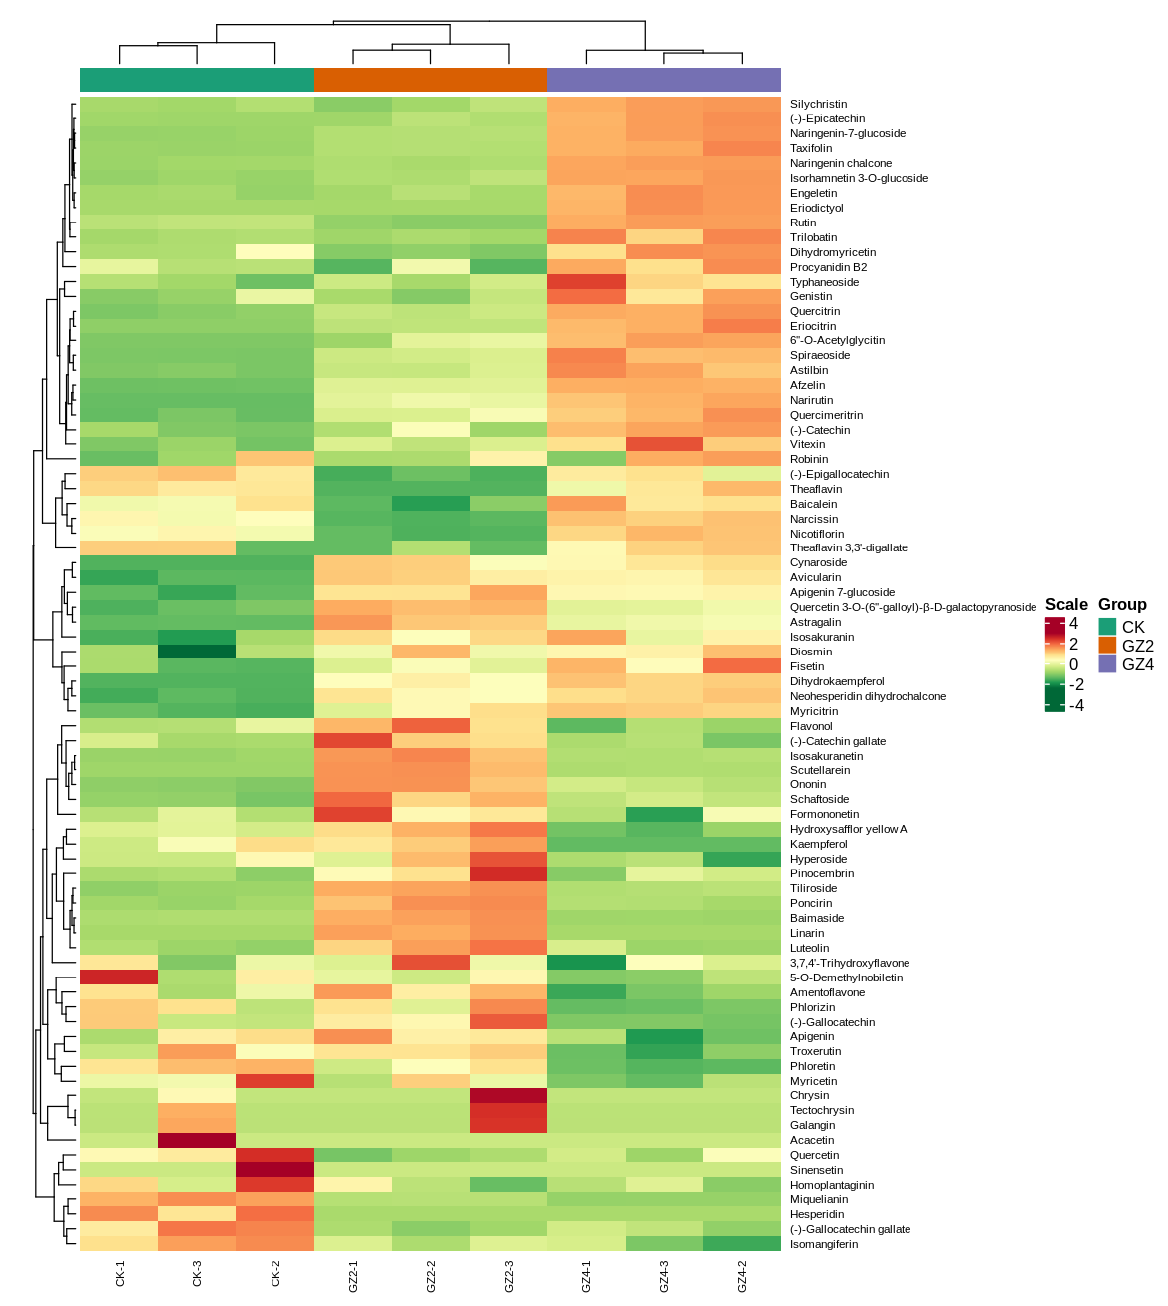
Figure 2. Heatmap of 78 flavonoid metabolites. The data on the flavonoid metabolite contents were normalized for hierarchical cluster analysis. Each column represents one sample, while each metabolite is represented by one row. Red color in the scale bars indicates an increase in relative metabolite abundance, while green color in the scale bars indicates a decrease, with the magnitude of change according to the scale (log 2 (fold change)).